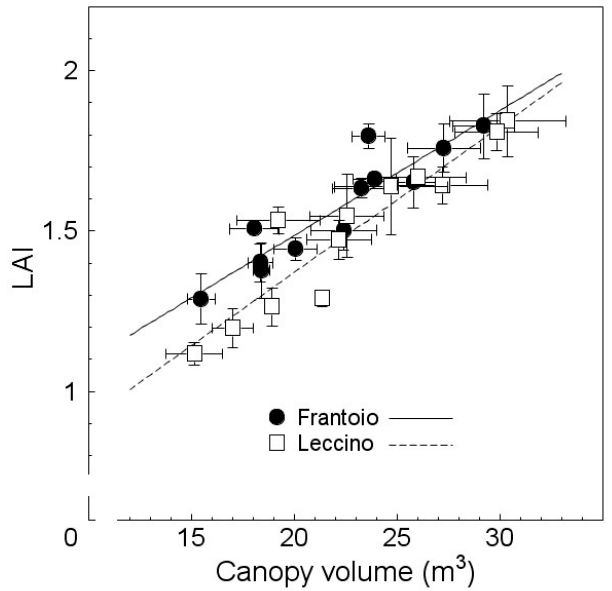
Figure 5. The relationship between canopy volume (CV) calculated by UAV-VIS imagery and Leaf Area Index (LAI) of olive trees (cvs. Frantoio and Leccino) subjected to full irrigation, deficit irrigation, or rainfed conditions in 2019 and 2020. LAI measurements were taken on DOY 232 in 2019 and DOY 170, 212, and 253 in 2020. Symbols are means of four trees ± standard errors. Regression equations: LAI = 0.04 CV + 0.71, R 2 = 0.84 (Frantoio); LAI = 0.05 CV + 0.46, R 2 = 0.88 (Leccino).